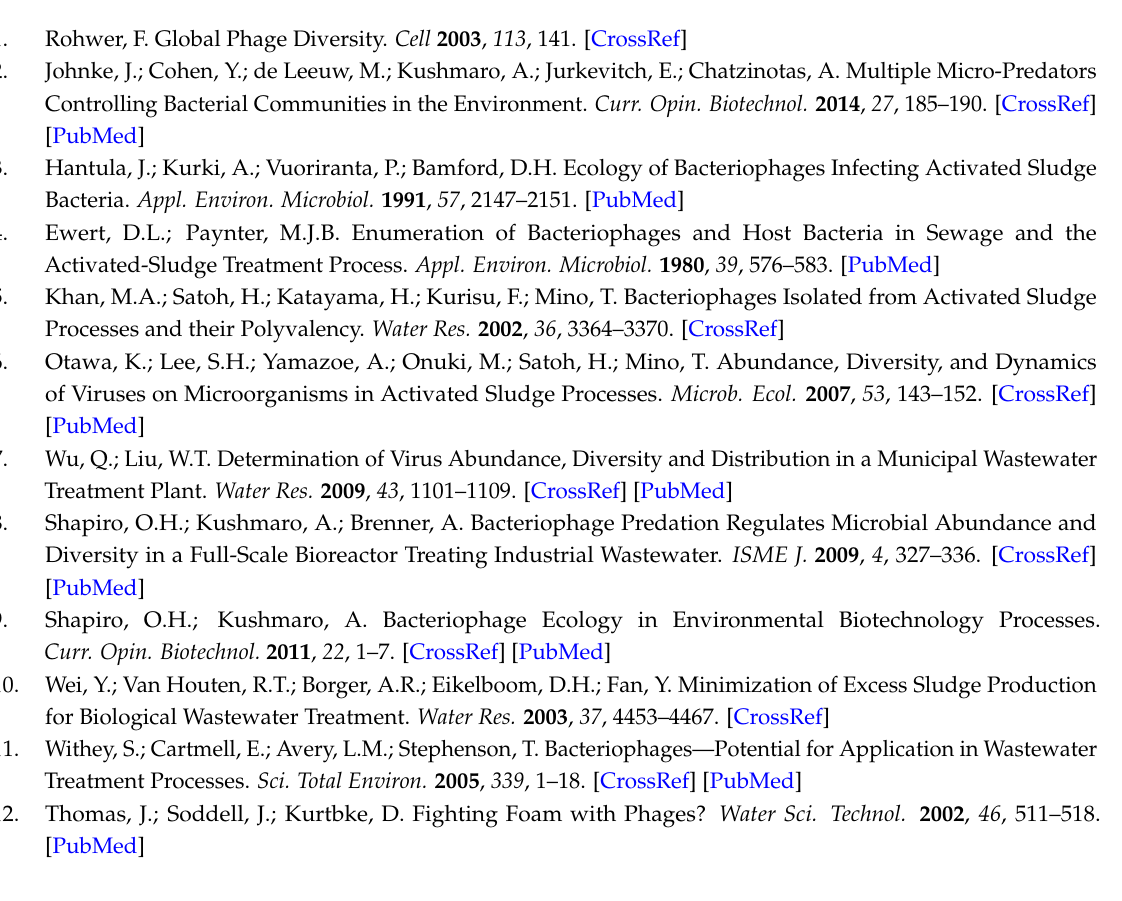
Figure S1: A phylogenetic tree of the bacteria, numbered H1–H18, tested in this work, Table S1: Open reading frames on the genome of the Aquamicrobium phage P14 and their domain matches found using